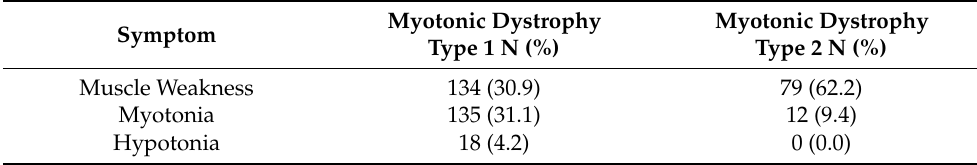
Table 3. Presenting symptoms in Myotonic Dystrophy Type 1 and Type